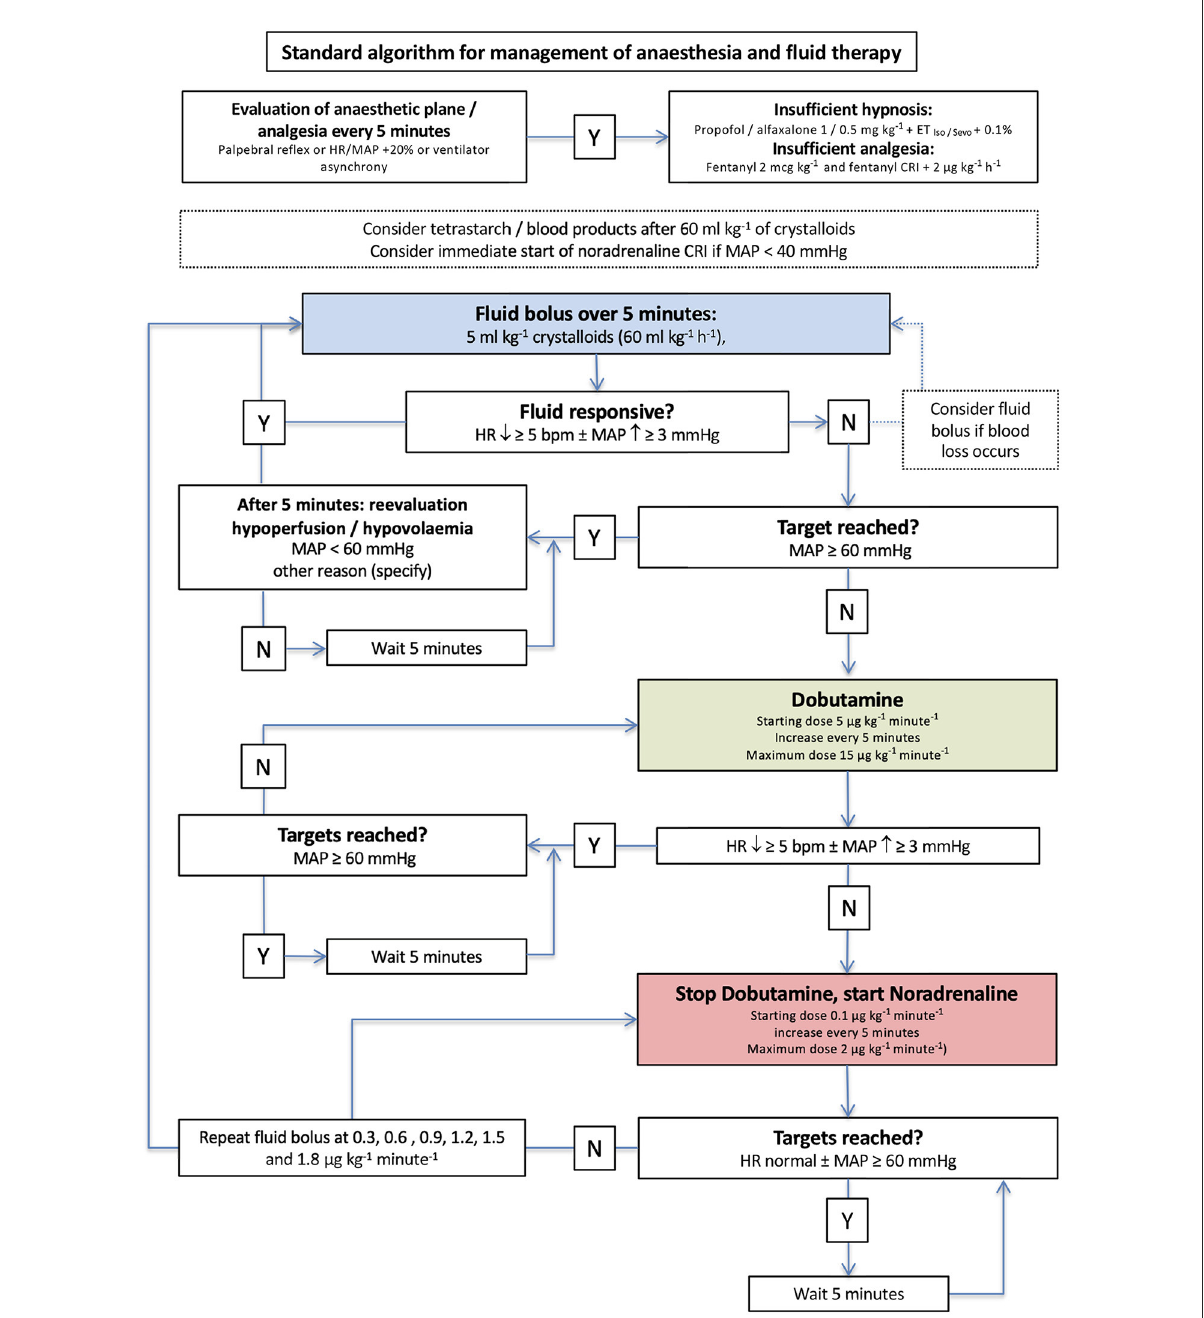
FIGURE2 Algorithm for management of anesthesia and goal-directed fluid therapy in group standard. The initial crystalloid bolus of 5 ml/kg was administered to every dog. Y, yes; N, no; iso, isoflurane; sevo, sevoflurane; IV, intravenous; CRI, continuous rate infusion; bpm, beats per minute.